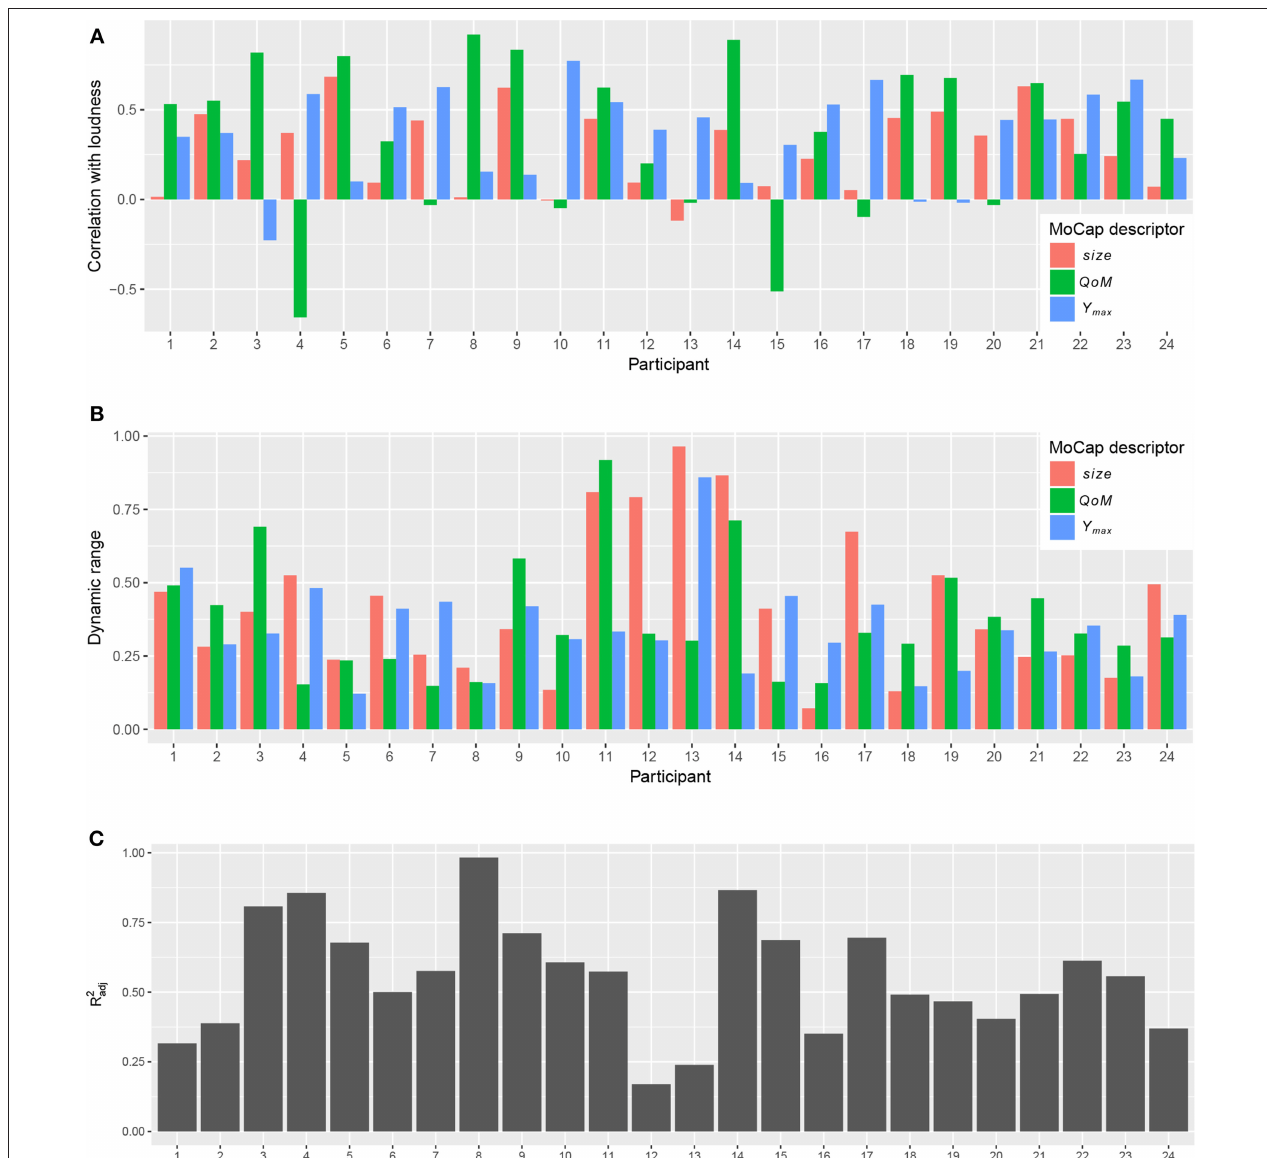
FIGURE 4 | Correlation with loudness, dynamic range of MoCap descriptors, and coefficient of determination for each participant computed from first Warm up phase. (A) Correlation of MoCap descriptors with loudness. (B) Dynamic range of MoCap descriptors. (C) Coefficient of determination ( R 2 adj ) of linear regression